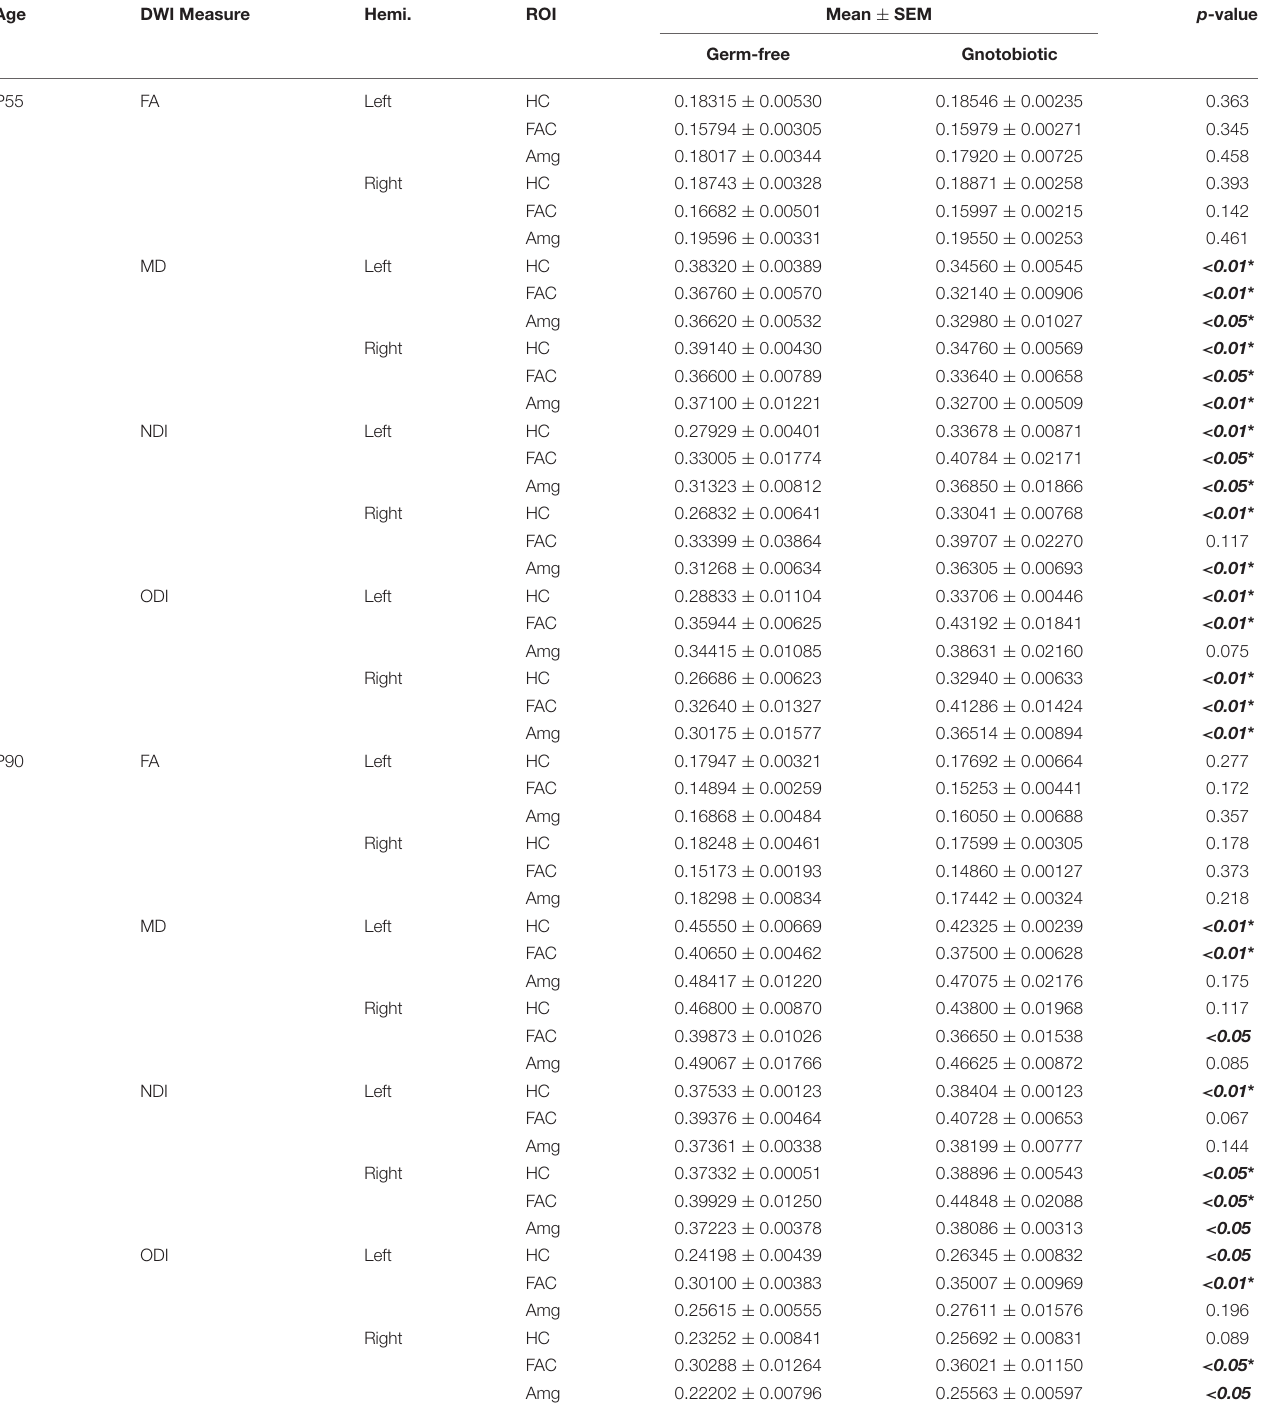
TABLE 1 | Humanized gut microbiota contribute to significant changes in quantitative neural microstructure in salient regions implicated in neurologic and psychiatric